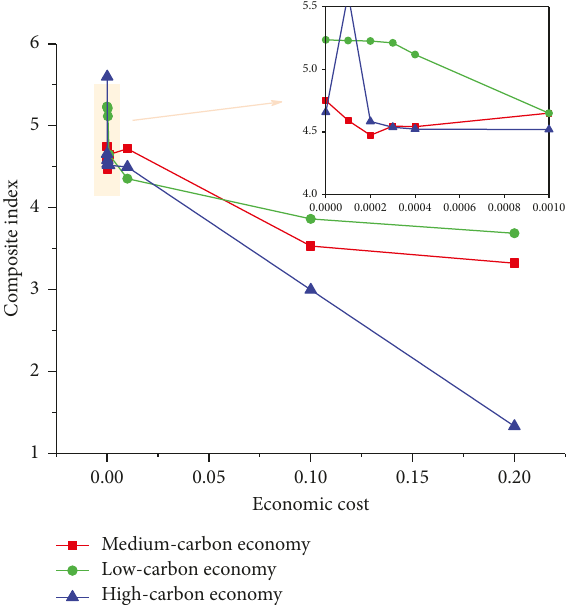
Figure 5: Various economic index